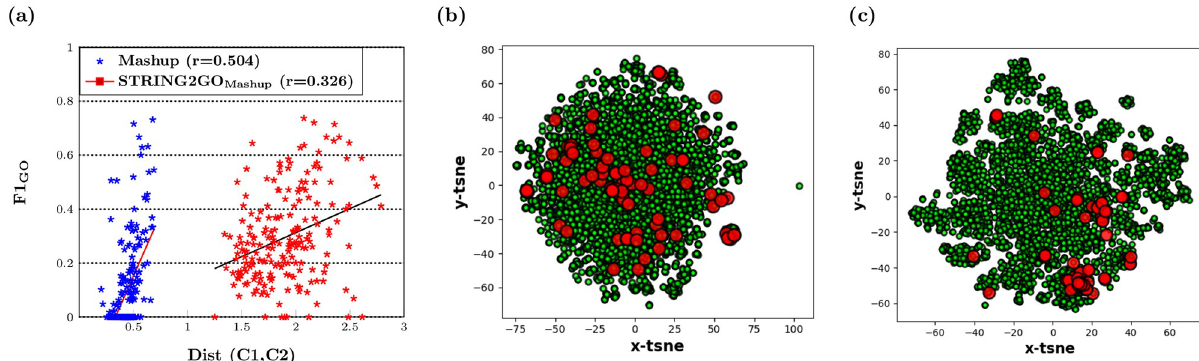
Fig 5. (a) Linear relationship between distances of two classes protein samples and F 1_GO scores obtained by Mashup-derived Combinedscore network embedding representations and the corresponding functional representations on Hold-out set testing (b) The 2D space visualization of distribution of protein samples belonging to GO:0090150 using the Mashup-derived network embedding representations and (c) the STRING2GO Mashup functional representations transformed by